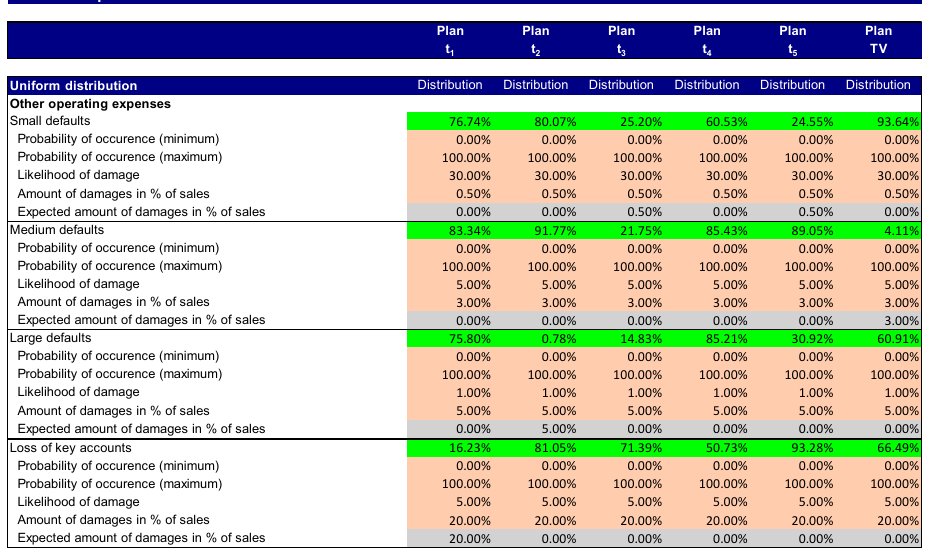
Figure 2. Distribution functions for other operating expenses.